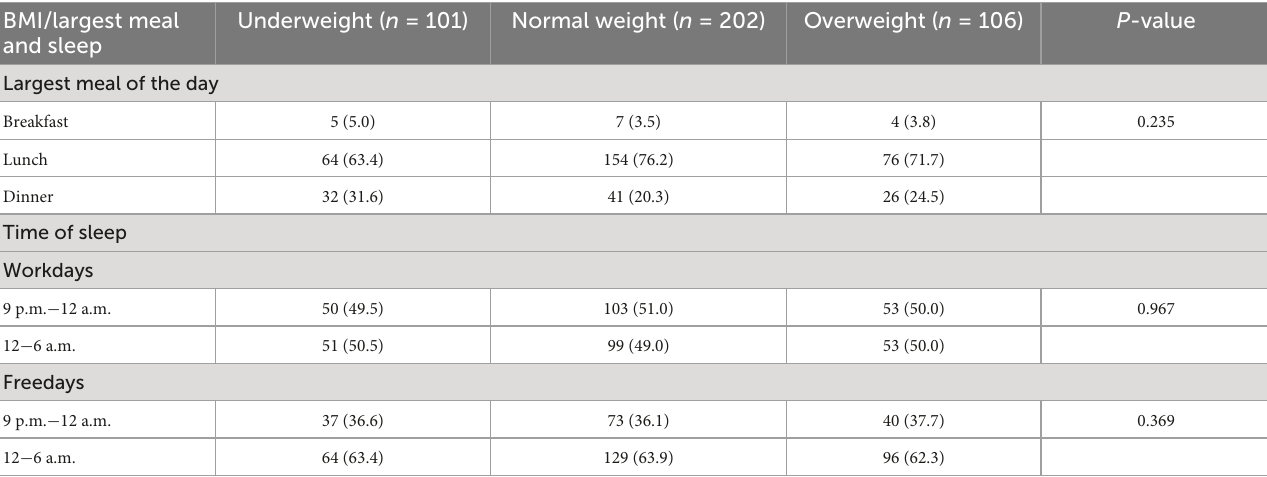
TABLE 3 Association between largest meal of the day and timing of sleep with